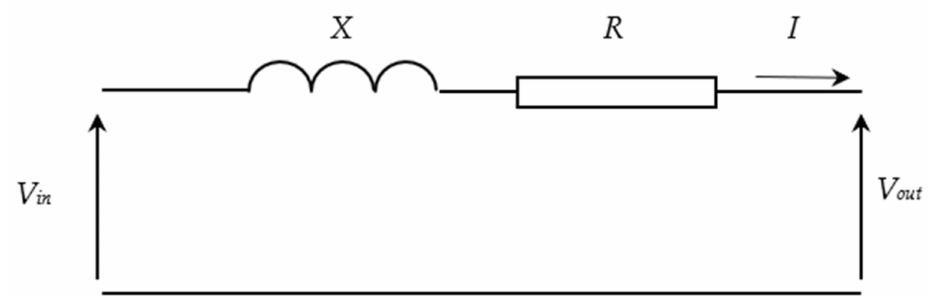
Figure 1. Simplified circuit diagram for the single-phase line model, where: V in —the input voltage of the line (voltage at the sending end), V ou t —the output voltage of the line (voltage at the receiving end), R —resistance of the line (which may also include the resistance of the transformer), X —line reactance (which may also include the reactance of the transformer), and I —line current.